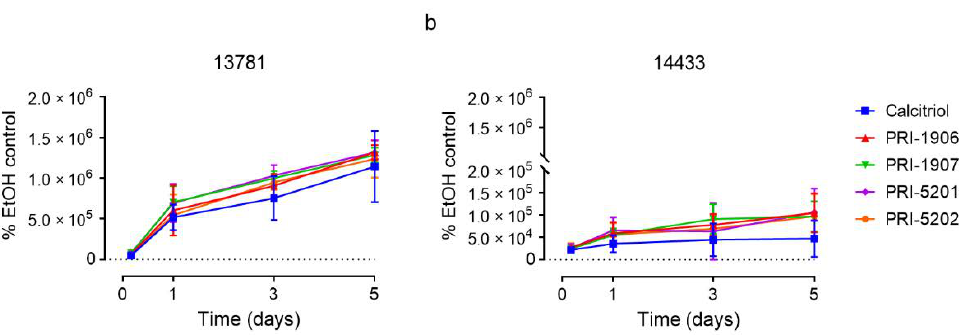
Figure 5. Expression of CYP24A1 in ( a ) 13781 and ( b ) 14433 cells after treatment with an1,25Ds at 100 nmol/L at different time points (4 h, 1 day, 3, and 5 days). The diagrams show the percentage increase compared with the ethanol control. N = 3.